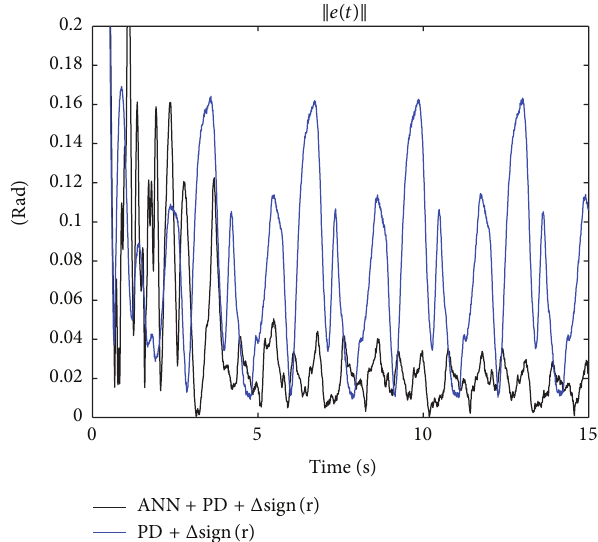
Figure 7: Time evolution of the norm of the tracking error ‖ e (𝑡)‖